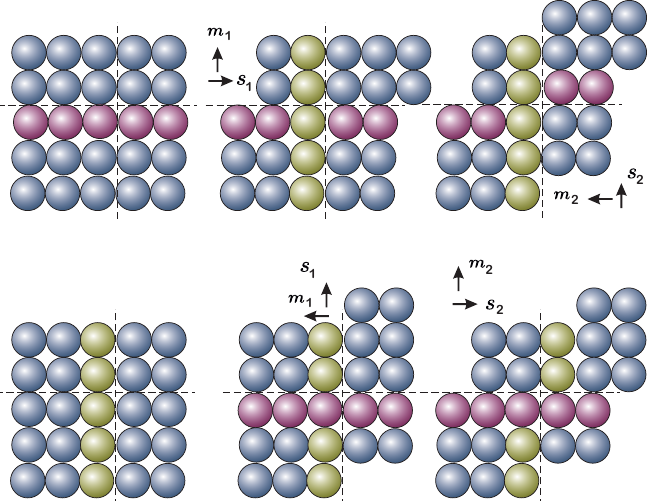
Figure 5. Comparison of the result obtained from two consecutive slips performed in different